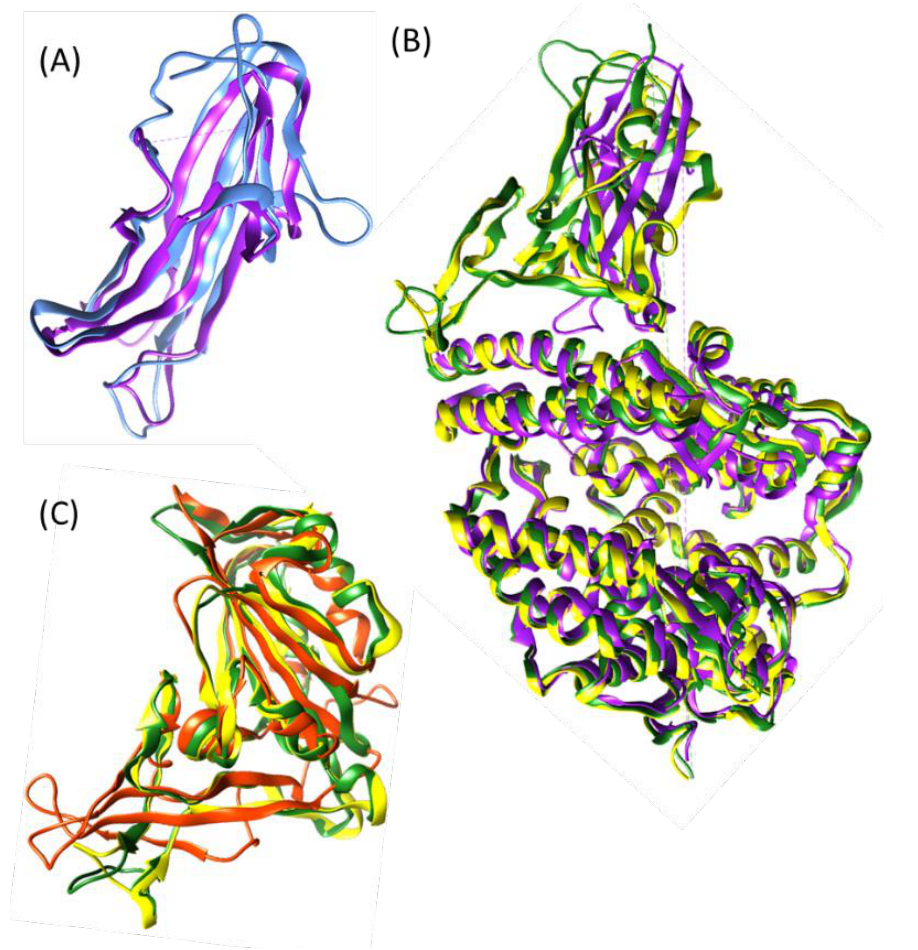
Figure 2. Structural alignments among some viral RBDs of human coronavirus using the US-align protocol [65] and the TM-align tool of the Zhang Lab suite [66]; ( A ): RBD of HCoV-NL63 (PDB: 3KBH,) with the RBD of HCoV-229E (PDB: 6ATK, in blue) alignment of 105 residues with TM-score = 0.83139 and RMSD 1.73; ( B ): RBD of SARS-CoV (PDB: 2AJF, in yellow) and SARS-CoV-2 (PDB: 6M0J, in green) bind the same ACE2 receptor as HCoV-NL63 (PDB: 3KBH, in purple); ( C ): Alignment from the three pandemic coronaviruses RBD (SARS-CoV, in yellow, SARS-CoV-2 in green and MERS-CoV RBD in orange) with TM-score = 0.7 in average, RMSD = 2.73 and 166 residues aligned among the three structures (154 residues aligned between Cov1 and MERS-CoV with TM-score = 0.69194, and 172 residues aligned between CoV-2 and MERS-CoV with TM-score = 0.70488).